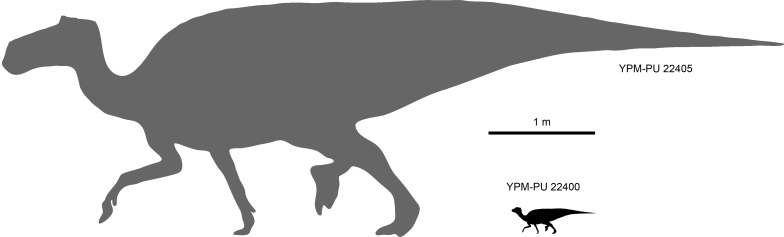
Size comparison between the perinatal individuals in YPM-PU 22400 and the presumably adult type specimen YPM-PU 44505.Adult length estimation from Horner, De Ricqlès & Padian (2000). Perinate scaled down from the adult based on femoral length comparison.